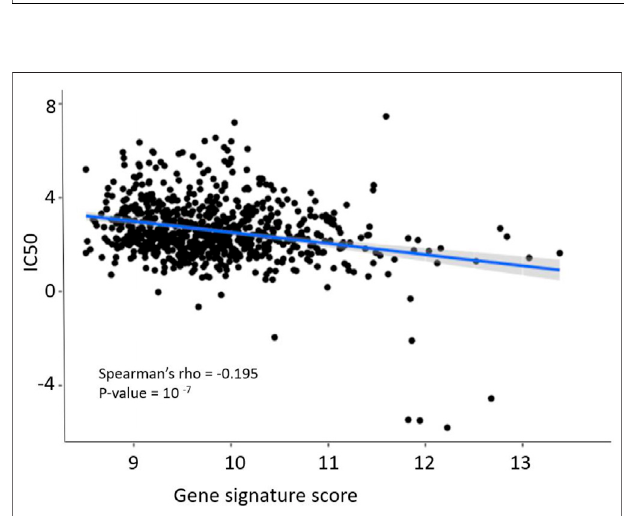
FIGURE 5 | Dependence of sorafenib resistance gene signature score andsorafenibIC 50 inGDSCpan-cancerdataset.Bluelineandshadowaround it show linear approximation and 5% con fi dence interval. Figure built using ggplot function in